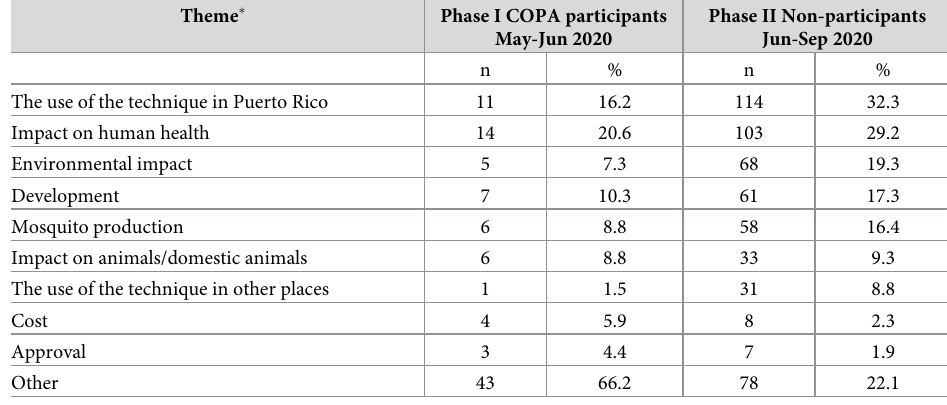
Table 4. Participants’ questions regarding the use of male mosquitoes with Wolbachia during follow-up survey, COPA, Ponce, Puerto Rico 2018–2019.